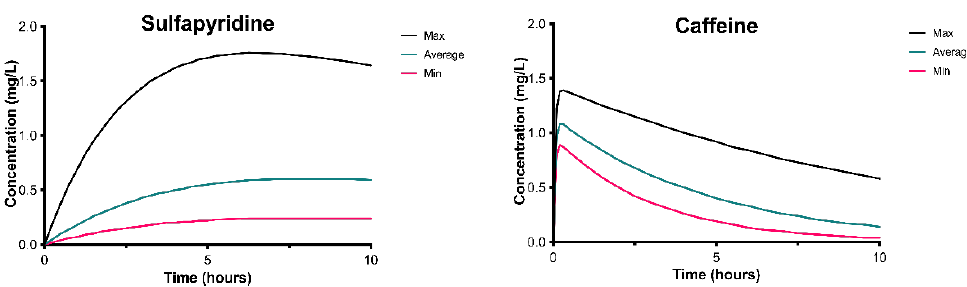
Figure A1. Plasma concentration of sulfapyridine and caffeine after oral administration of 125 mg sulfasalazine and 50 mg caffeine to a person with a body weight of 70 kg. The maximum, average, and minimum expected plasma concentration profiles are given based on pharmacokinetic parameters obtained from the literature [30,31].